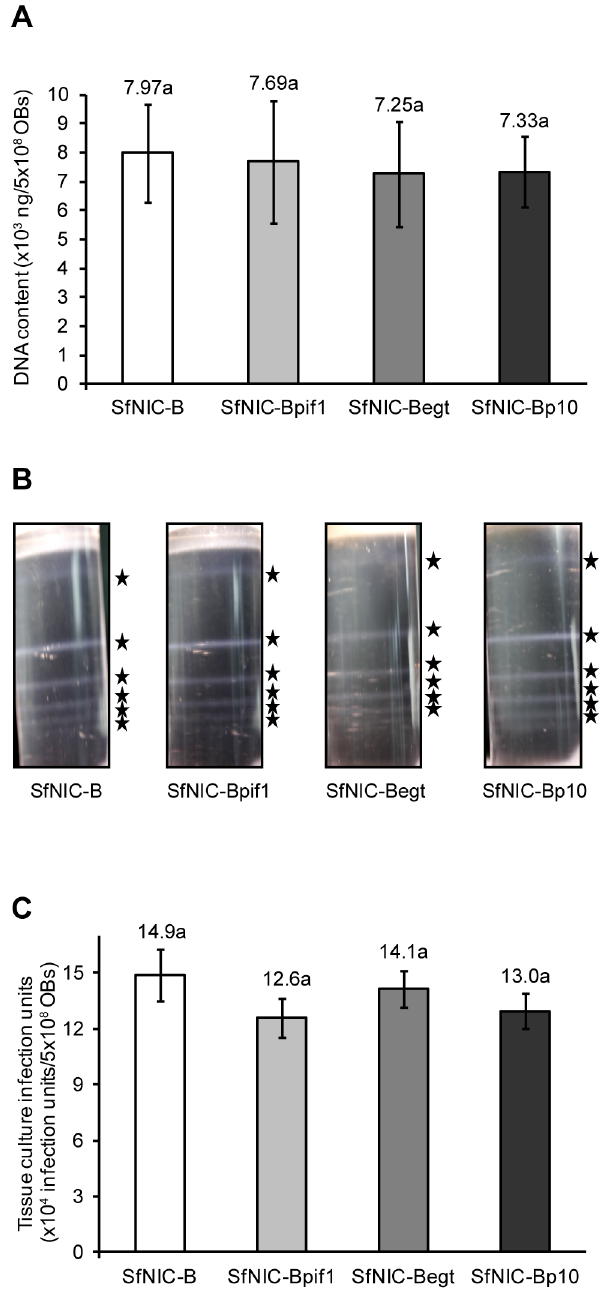
Figure 3. DNA and genome content of Occlusion Bodies. A) Mean amounts of DNA (ng/ m l) extracted from samples of 5 6 10 8 OBs of SfNIC-B, SfNIC-Bpif1, SfNIC-Begt and SfNIC-Bp10 viruses and determined by qPCR. Mean amounts of DNA from OB samples did not differ significantly between viruses (ANOVA, P=0.401). B) ODV banding patterns of SfNIC-B, SfNIC-Bpif1, SfNIC-Begt and SfNIC-Bp10 viruses after sucrose-gradient separation of ODVs from similar quantities of occlusion bodies (5 6 10 8 OBs). Stars indicate the positions of the observed ODV bands. C) ODV content in 5 6 10 8 OBs of SfNIC-B, SfNIC- Bpif1, SfNIC-Begt and SfNIC-Bp10 viruses. Sf9 cells were infected with serial dilutions (1:10, 1:50, 1:250, 1:1250, 1:6250) of ODVs released from OBs. ODV titers (ODV/ml) were calculated by end-point dilution. No significant differences were observed in the ODV content of OBs of the different viruses (ANOVA,